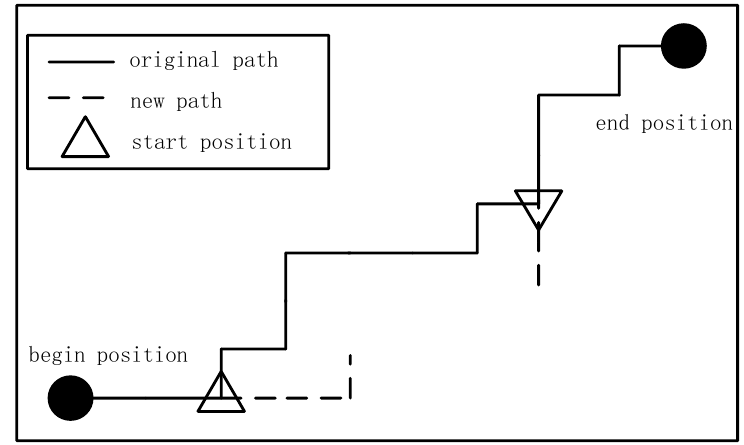
Figure 9. Employed bee looks for the new food source.